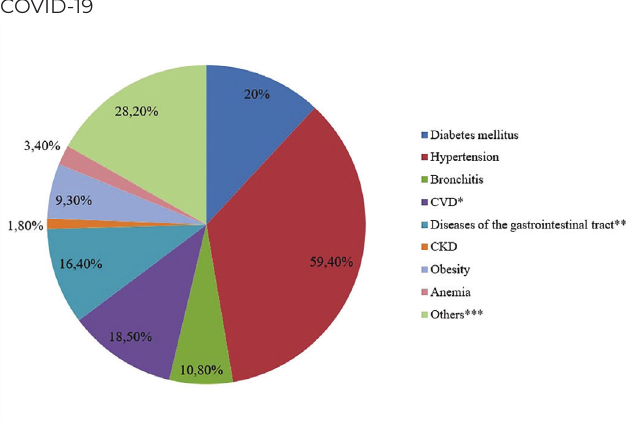
Figure 1 - The structure of comorbidities in patients with COVID-19